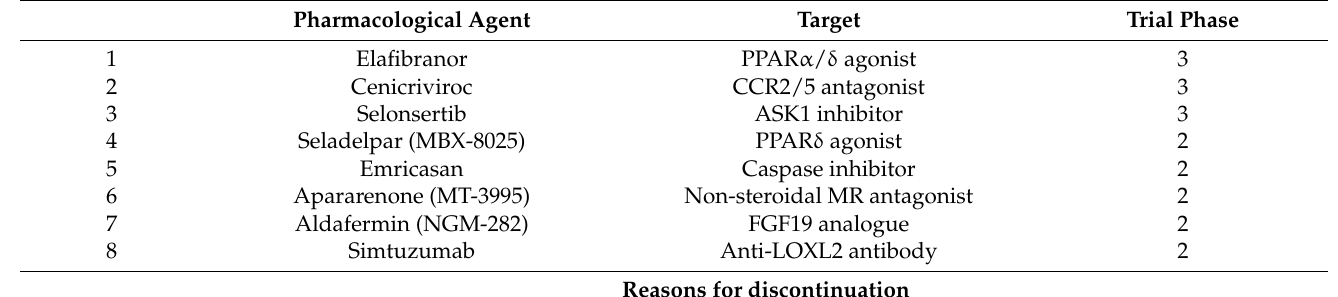
Table 2. Drugs with suspended or discontinued